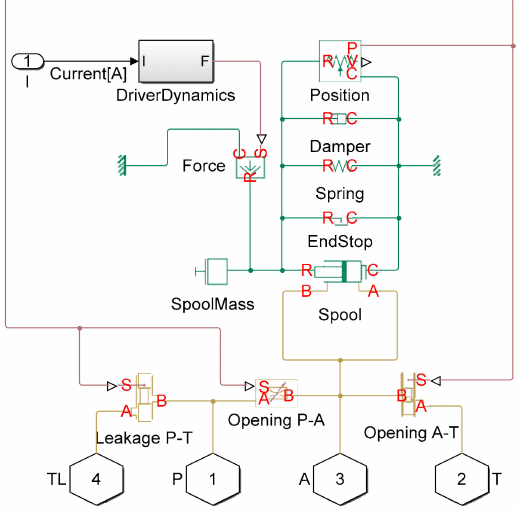
Figure 8. Modeling of direct acting proportional pressure control valve using MATLAB 2015b/Simulink